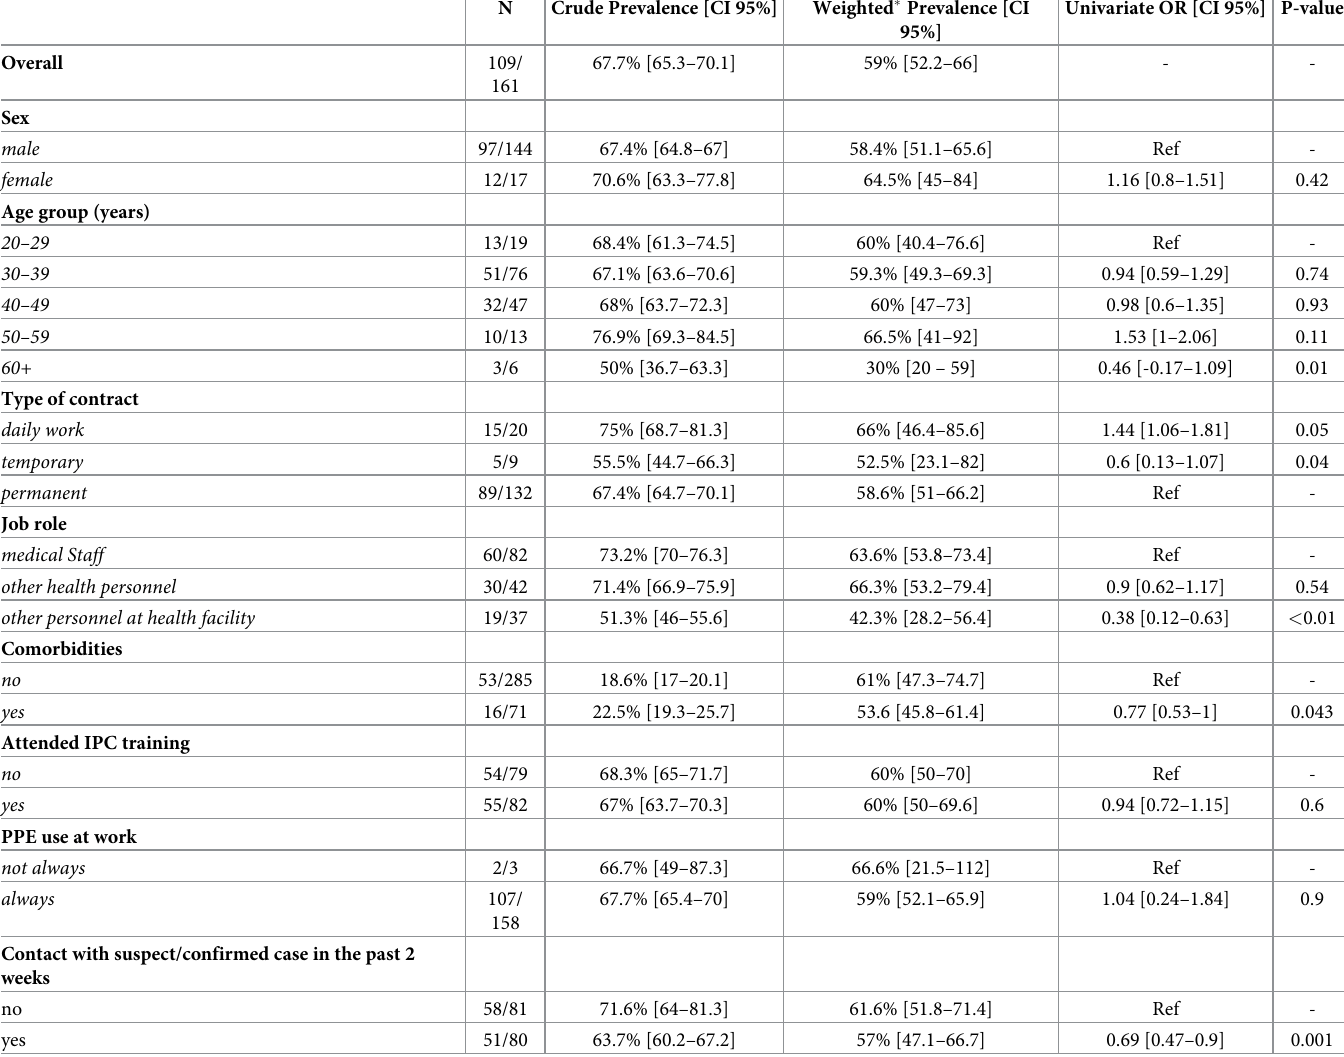
Table 2. Univariable analyses for risk factors of seropositivity to SARS-CoV-2 in 161 participants in the MSF Aden Trauma Center.